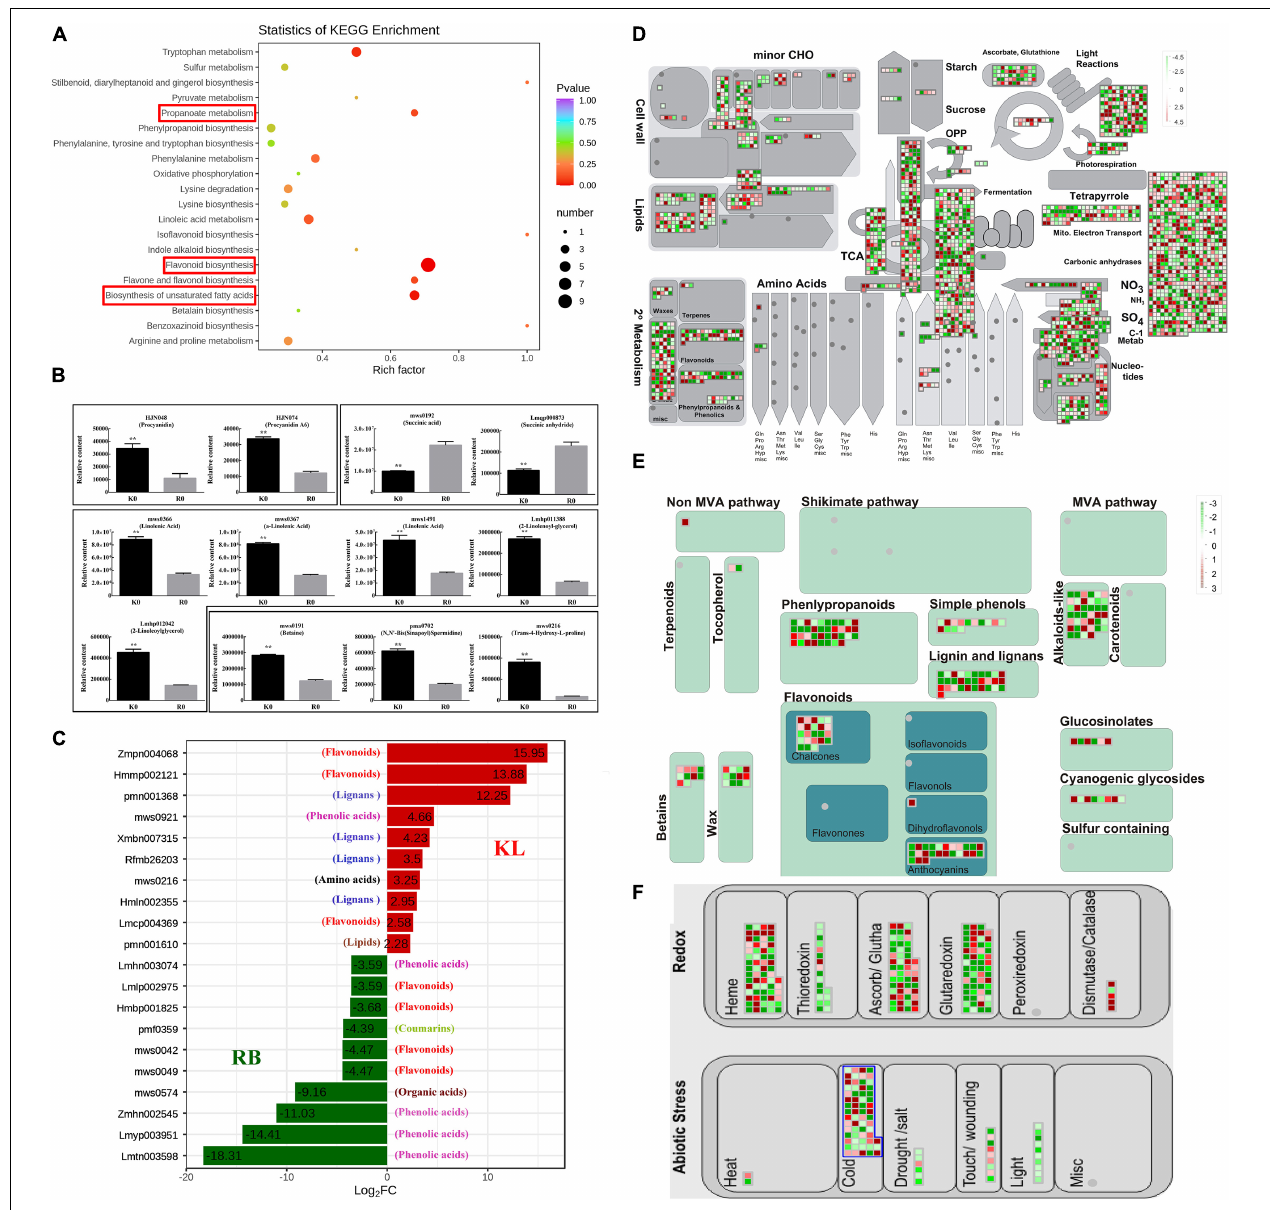
FIGURE 4 | Comparison of the DEMs and DEGs between KL and RB under the no-freezing condition. (A) KEGG pathway enrichment analysis of DEMs. (B) DEMs were involved in flavonoid biosynthesis, propanoate metabolism and biosynthesis of unsaturated fatty acids. (C) Top 10 DEMs are shown for each genotype. (D) Overview of the pathways analyzed, via Mapman, in the DEGs of KL and RB under the no-freezing condition (0 h/ − 25 ◦ C). (E) DEGs involved in the secondary metabolism pathway. (F) DEGs involved in the redox metabolism pathway. These values are the medians from log2 (fold-change) values for each DEG. Red and green denote up-regulation and down-regulation,